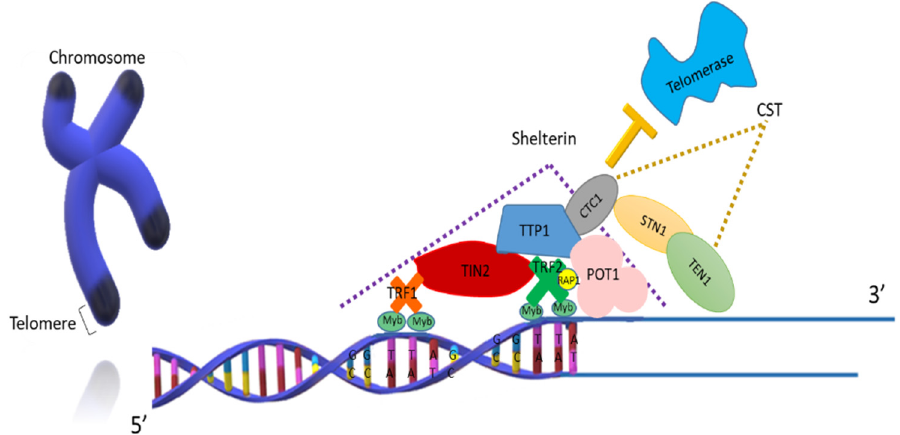
Figure 1. Structure of the shelterin and CTC1-STN1-TEN1 (CST) complexes. The shelterin complex is made up of the proteins telomeric repeat-binding factor 1 (TRF1), telomeric repeat-binding factor 2 (TRF2), TRF1-interacting nuclear factor 2 (TIN2), adrenocortical dysplasia protein homolog (TPP1), protection of telomeres protein 1 (POT1), and repressor activator protein 1 (RAP1). TRF1 and TRF2 subunits bind to the double-stranded telomeric DNA using Myb-type domains and the POT-1 subunit binds to the single-stranded. On the other hand, the CST complex made up of the proteins CTC1, STN1, and TEN1 inhibits the activity of the telomerase enzyme.